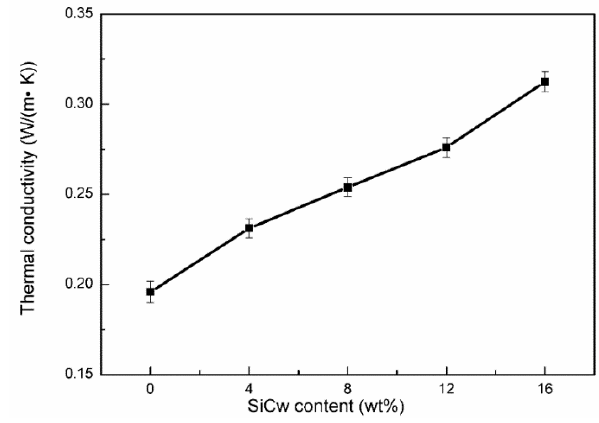
Figure 4. Thermal conductivity of SiCw/hydro-epoxy composites with different SiCw amounts.